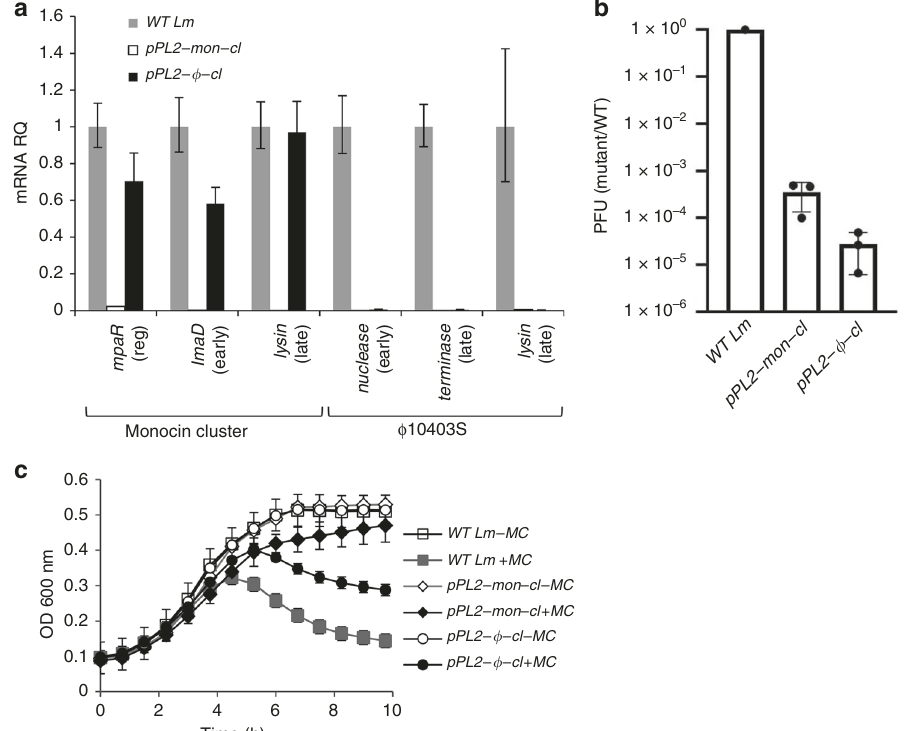
Fig. 6 The monocin cluster CI-like repressor regulates ϕ 10403S induction. a qRT-PCR transcription analysis of monocin cluster and ϕ 10403S representative genes in WT bacteria and bacteria constitutively over-expressing mon-CI-like or ϕ -CI-like repressors from pPL2 (pPL2 -mon-cI and pPL2 - ϕ - cI , respectively), 4 h post MC treatment at 30 ˚ C. Transcription levels are presented as relative quantity (RQ), relative to their levels in WT bacteria. The data represent 3 independent experiments. Error bars indicate a 95% con fi dence interval. b A plaque forming assay performed on WT Lm or bacteria constitutively over-expressing mon-CI-like or ϕ -CI-like repressors from pPL2 (pPL2 -mon-cI and pPL2 - ϕ -cI , respectively), 4 h post MC treatment at 30 ˚ C. The results were normalized to the results with WT bacteria. Error bars represent the standard deviation of three independent experiments. c Growth analysis of WT Lm or bacteria constitutively over-expressing mon-CI-like or ϕ -CI-like repressors from pPL2 under the constitutive veg promoter (pPL2 - mon-cI and pPL2 - ϕ -cI , respectively) with or without MC. The data shows the mean and the standard deviation of three independent biological repeats. Source data are provided as a Source Data fi